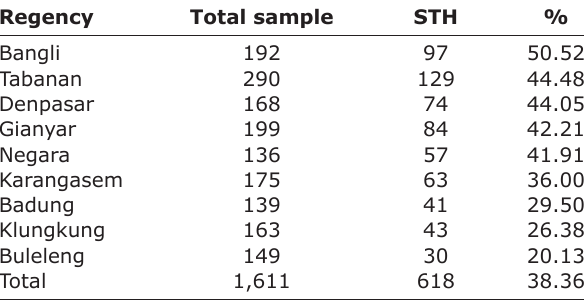
Table-1: The prevalence of STH infection in free-roam dogs and its distribution in Bali Province.